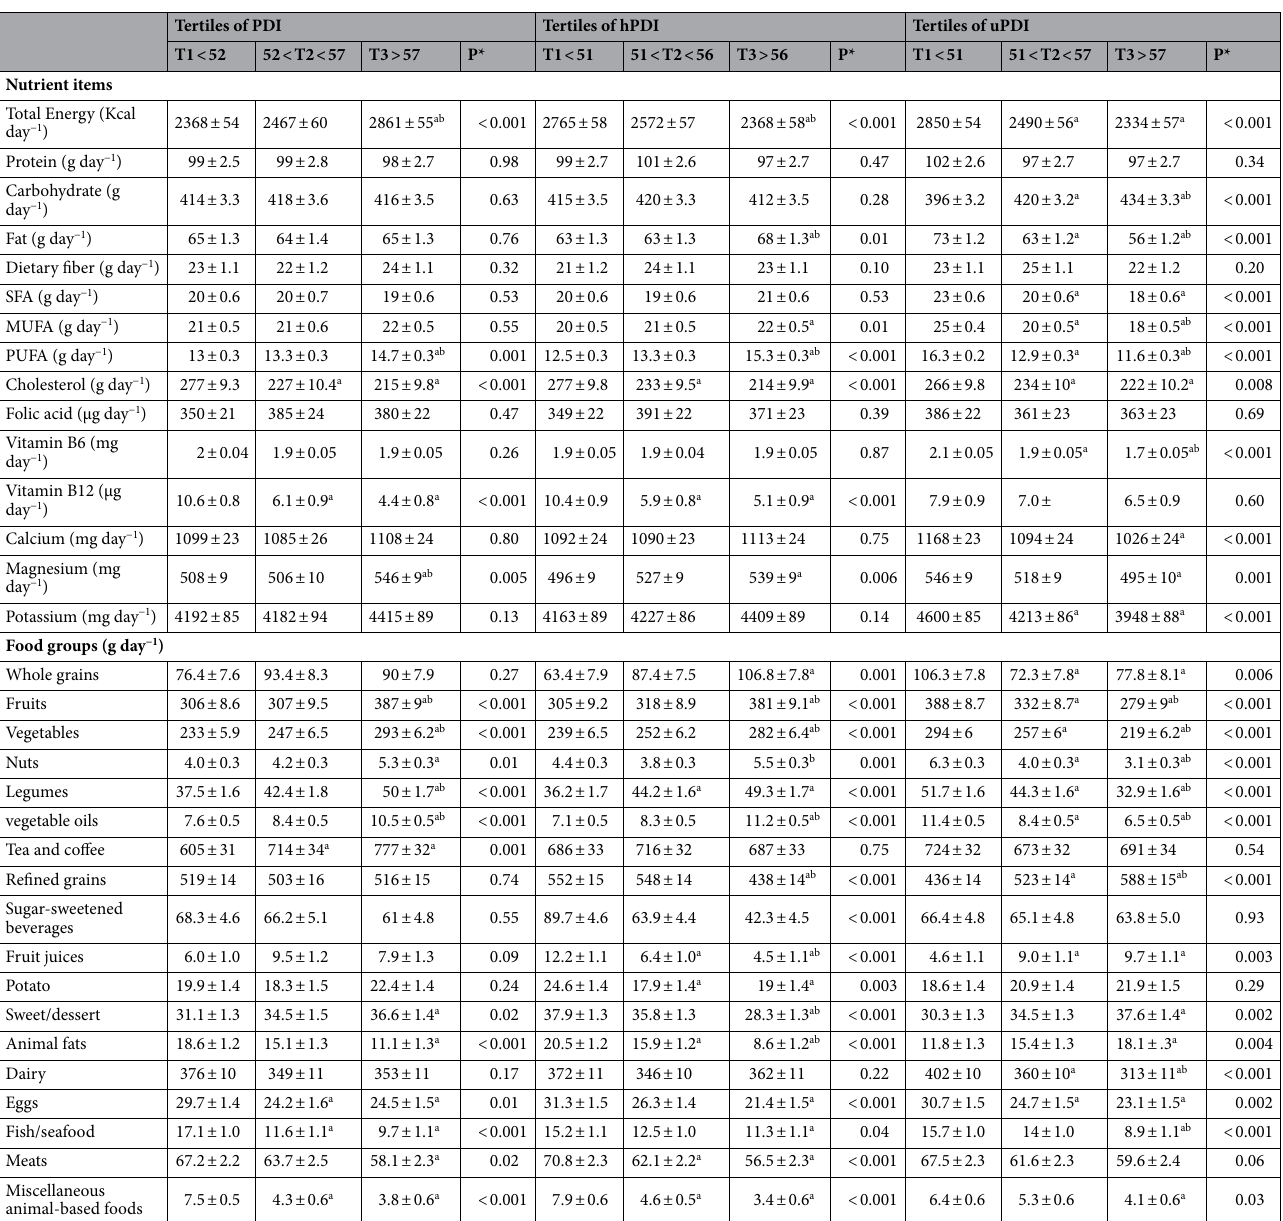
Table 3. Dietary intakes of study participants across tertiles of PDI, hPDI, and uPDI scores. PDI overall plant- based diet index, hPDI healthy plant-based diet index, uPDI unhealthy plant-based diet index, SFA saturated fatty acid, PUFA polyunsaturated fatty acid, MUFA monounsaturated fatty acid. Data are presented as mean ± SE. *All values, except energy intake, were adjusted for energy intake using ANCOVA with Bonferroni correction. a Significant compared with T1. b Significant compared with